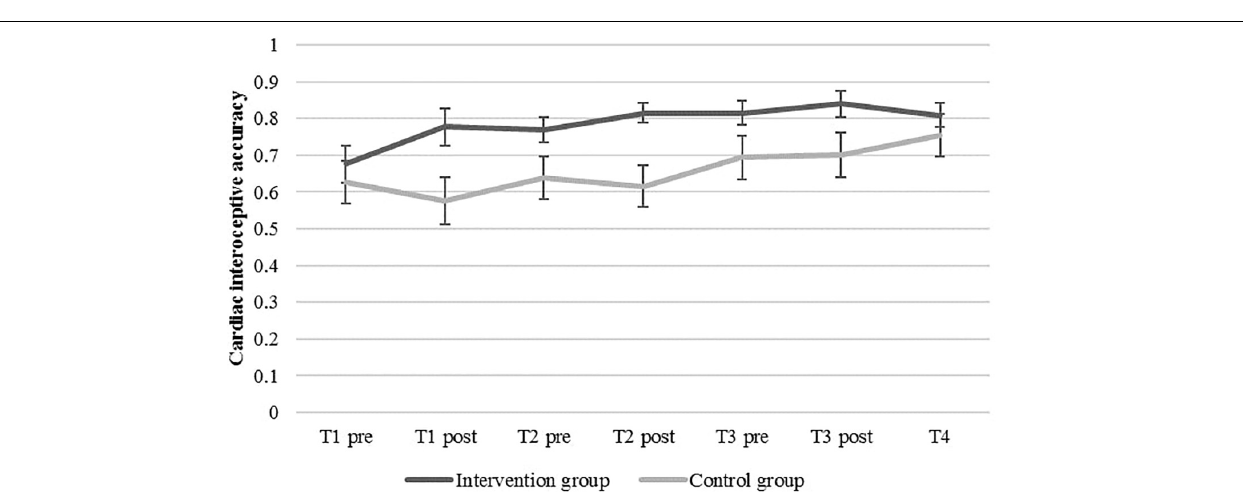
FIGURE 3 | Mean cardiac interoceptive accuracy and standard errors in the intervention and the control group at baseline (T1 pre ), before and after each of the three heartbeat perception training sessions (pre vs. post), and post-measurement